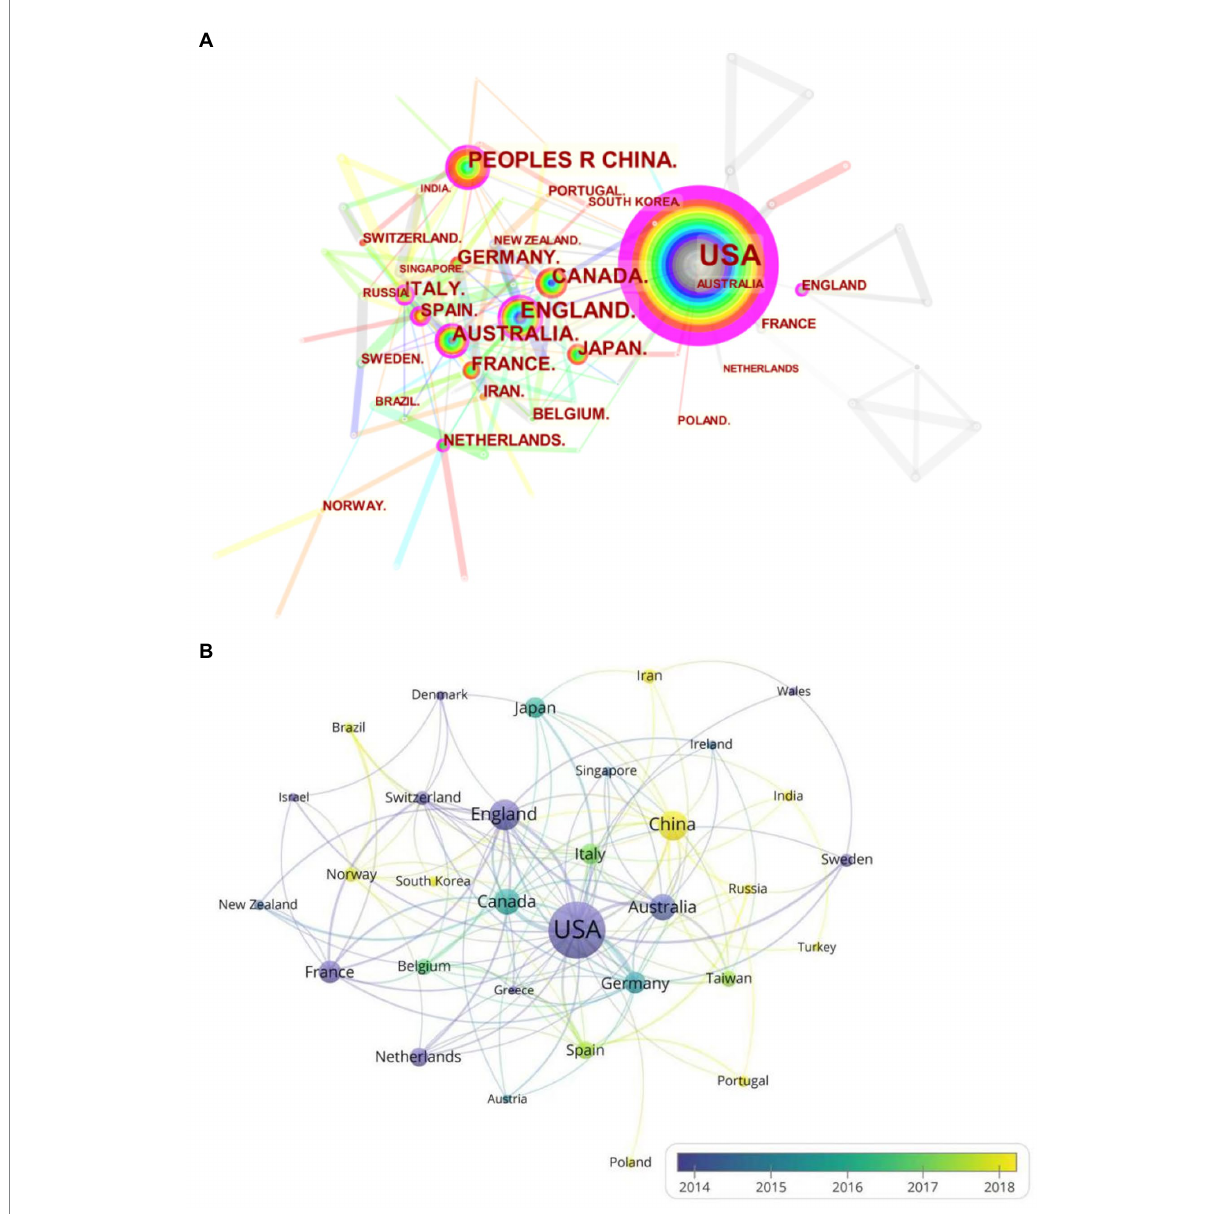
FIGURE 3 (A) The cooperation network visualizations map of countries and regions based on CiteSpace; (B) The average annual publication year map of countries and regions based on